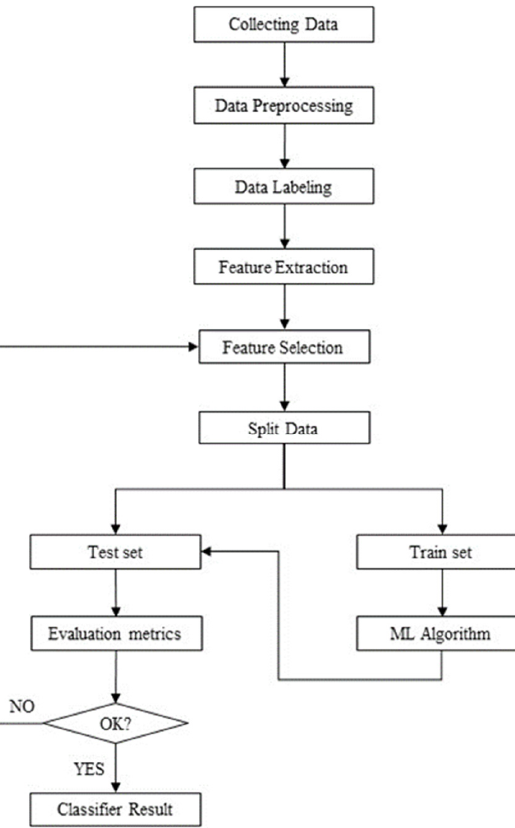
Figure 2. Proposed model for detecting evidence tweets .